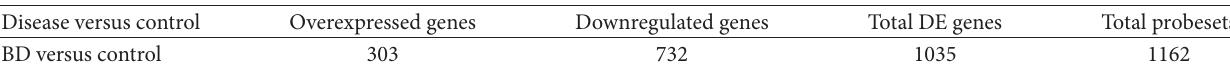
scale and as downregulated when they present negative FC, in log 2 > |0.37|